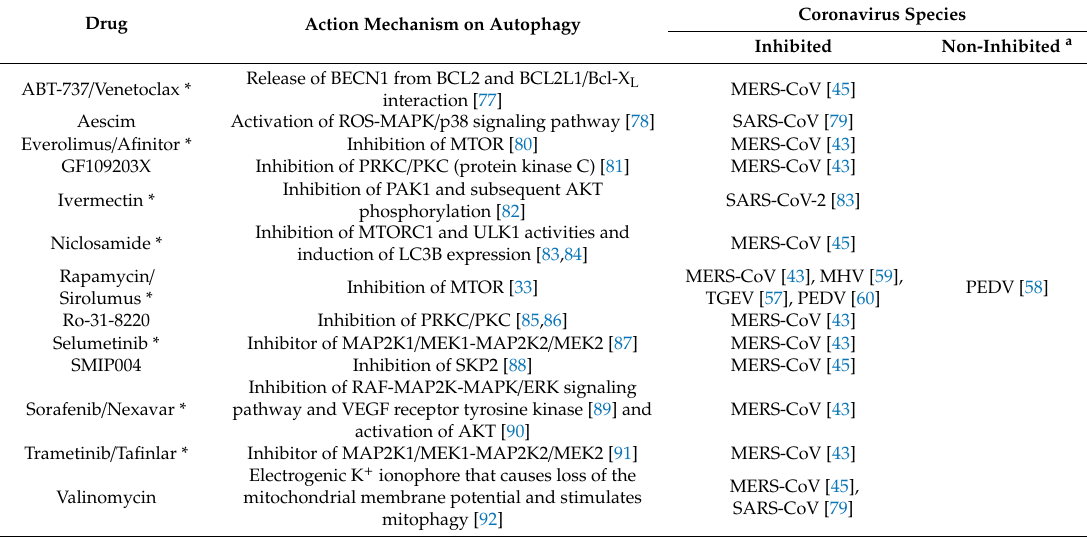
Table 4. E ff ect of autophagy inducers on the replication levels of coronavirus in cell cultures. Drug Action Mechanism on Autophagy Coronavirus Species Inhibited Non-Inhibited